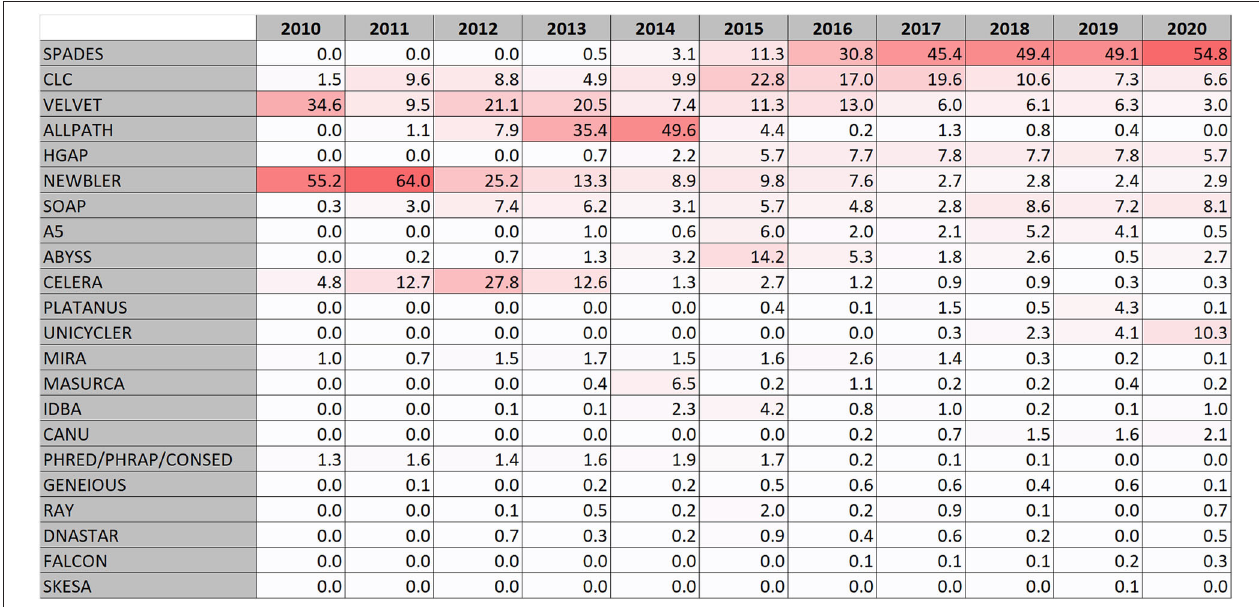
FIGURE 2 | Heatmap of the most frequently used genome assembly software solutions